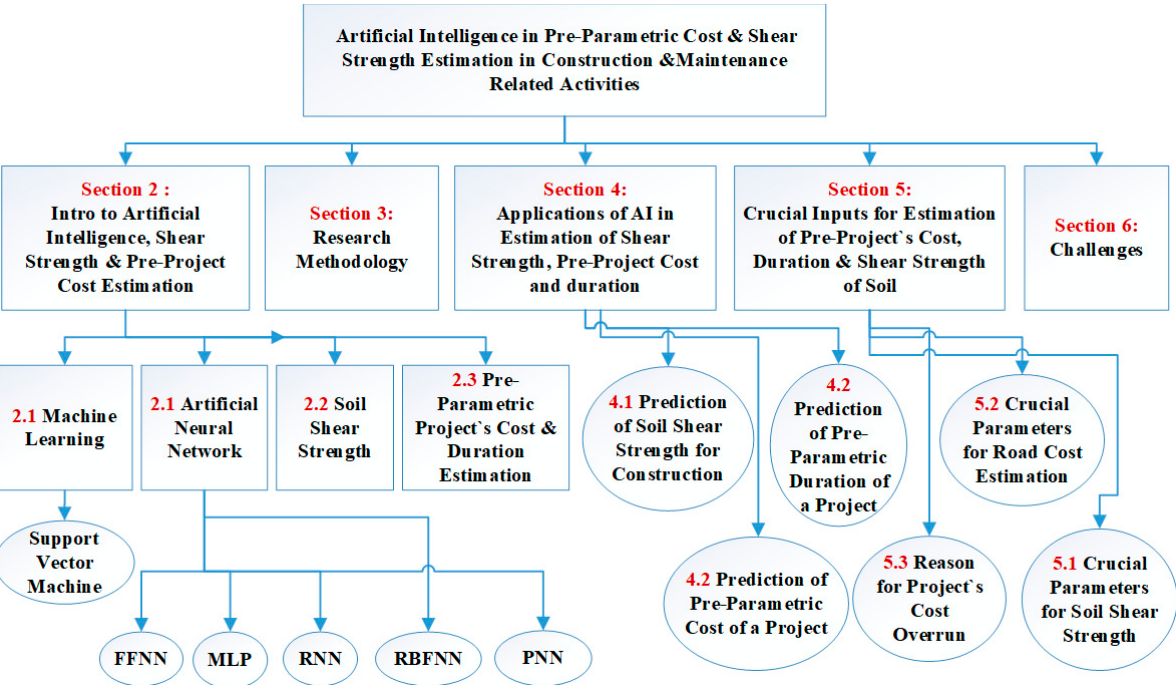
Figure 1. Blueprint of this paper.